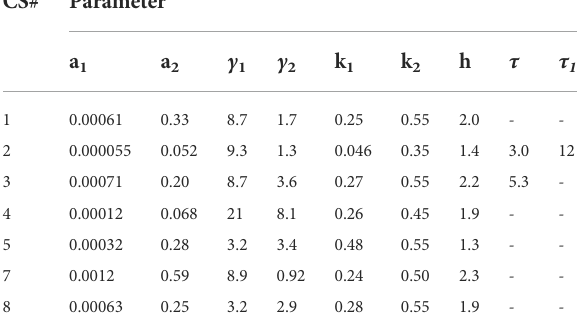
TABLE 1 Parameters obtained from fi tting the coupled Model 1 to the seven CS subjects. CS#